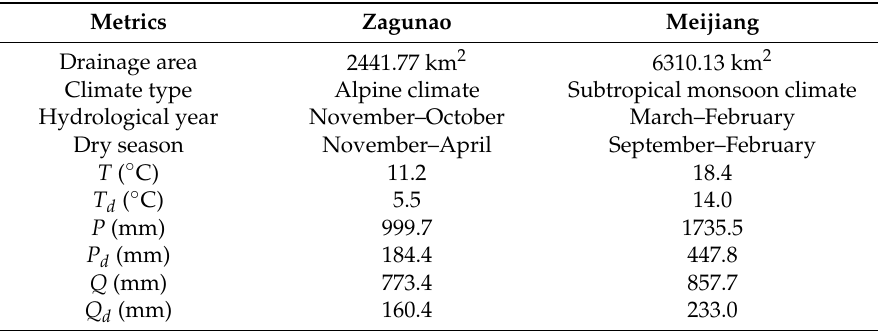
Table 1. A summary of watershed characteristics.